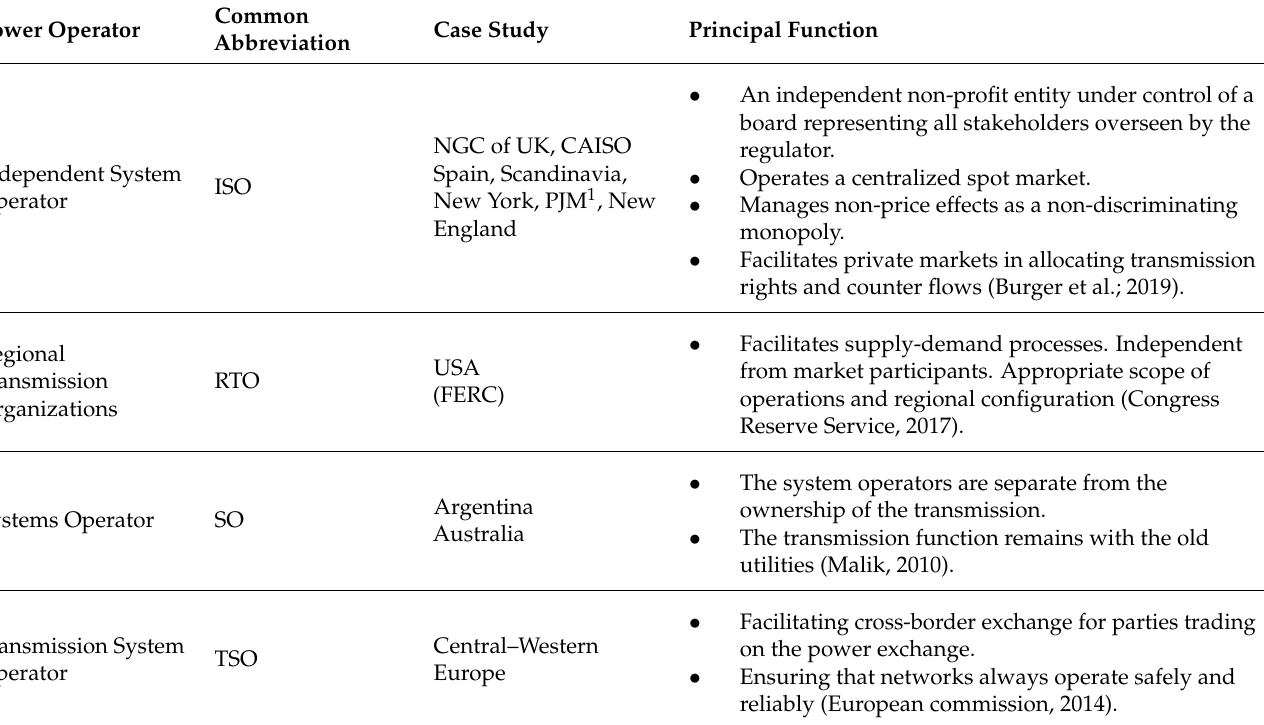
Table 7. Common institutional structure and coordination of electricity